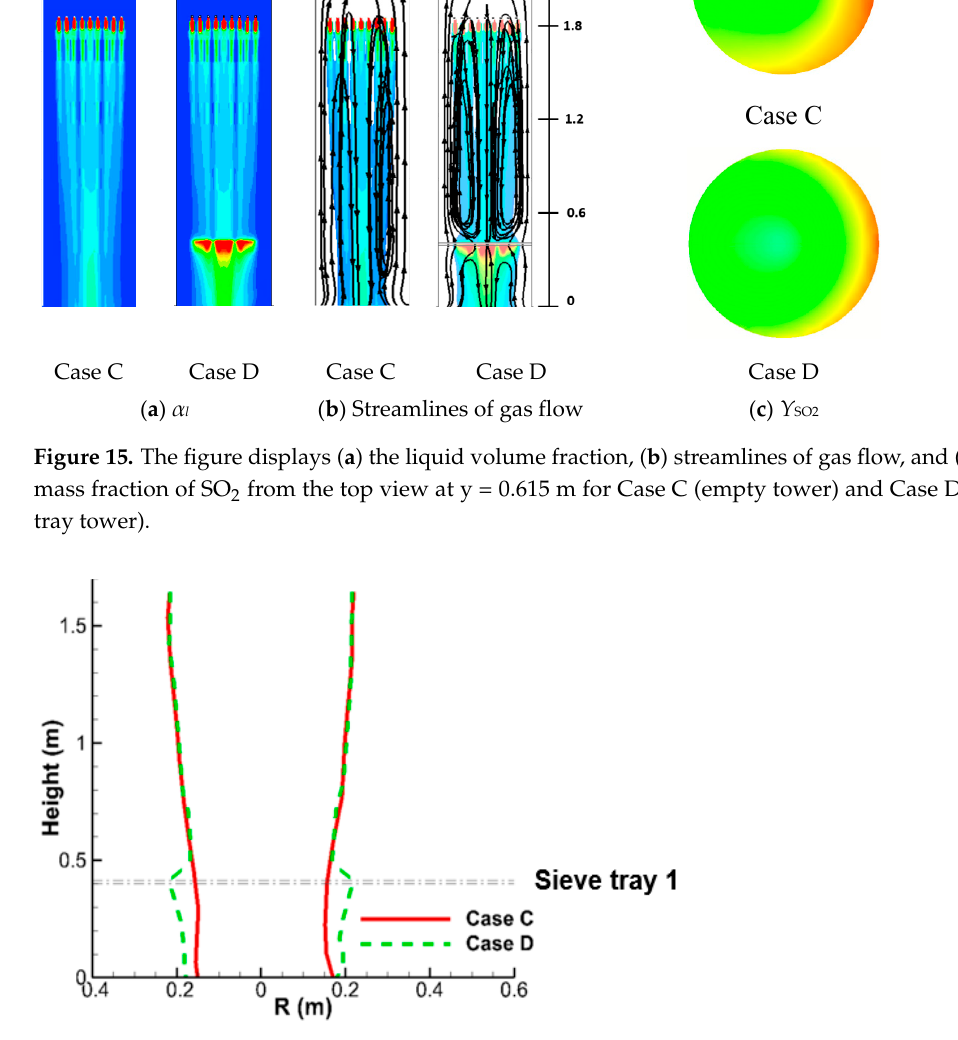
only one tray perform better than Case A (57.1%).